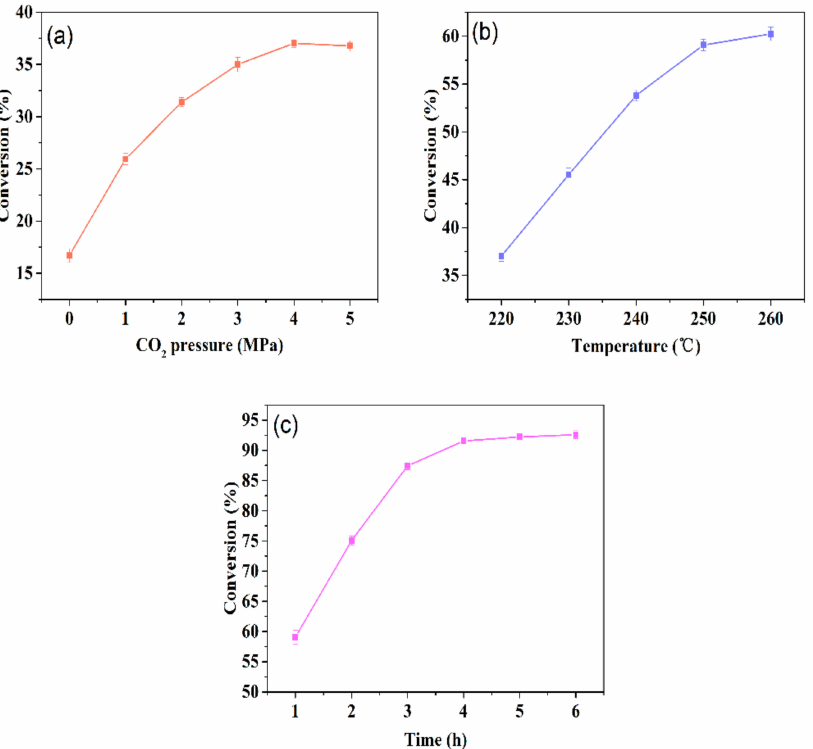
Figure 2. Hydrogenated rosin conversion versus various reaction conditions. Reaction conditions: stirring speed, 400 r / min; the molar ratio of hydrogenated rosin to xylitol, 1:1. ( a ) Temperature, 220 ◦ C; time, 1 h. ( b ) Pressure of CO 2 , 4 PMa; time, 1 h. ( c ) Pressure of CO 2 , 4 PMa; temperature, 250 ◦ C.